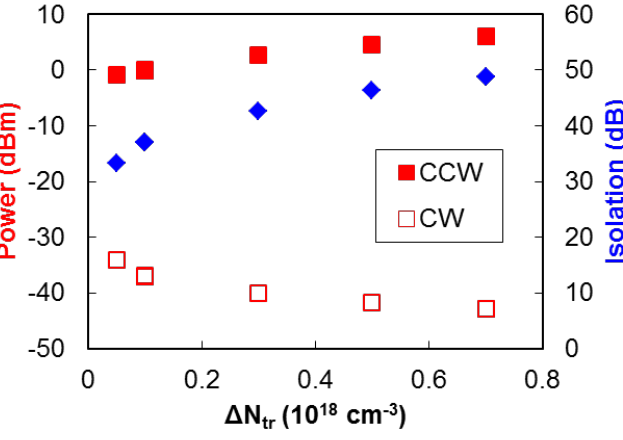
Figure 6. Average output power for the clockwise (CW) and counter-clockwise (CCW) signals, assuming Δ T = 12.5 ps in Figure 5a, as a function of the modulation amplitude Δ N tr of N tr . The isolation ratio is also shown (blue). The SOA injection current is 80 mA. Further MLL design parameters are as in Figure